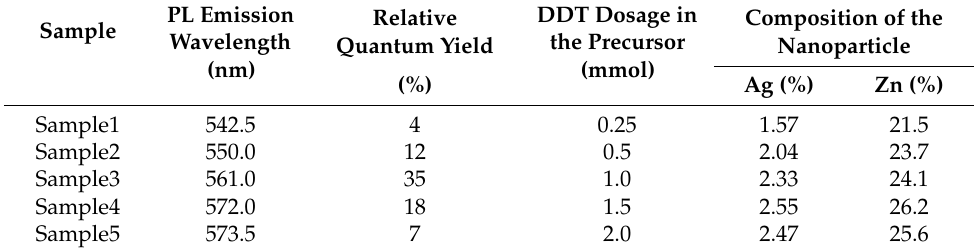
Table 2. Chemical compositions and photoluminescence (PL) emission properties of ZAIS-4 NCs